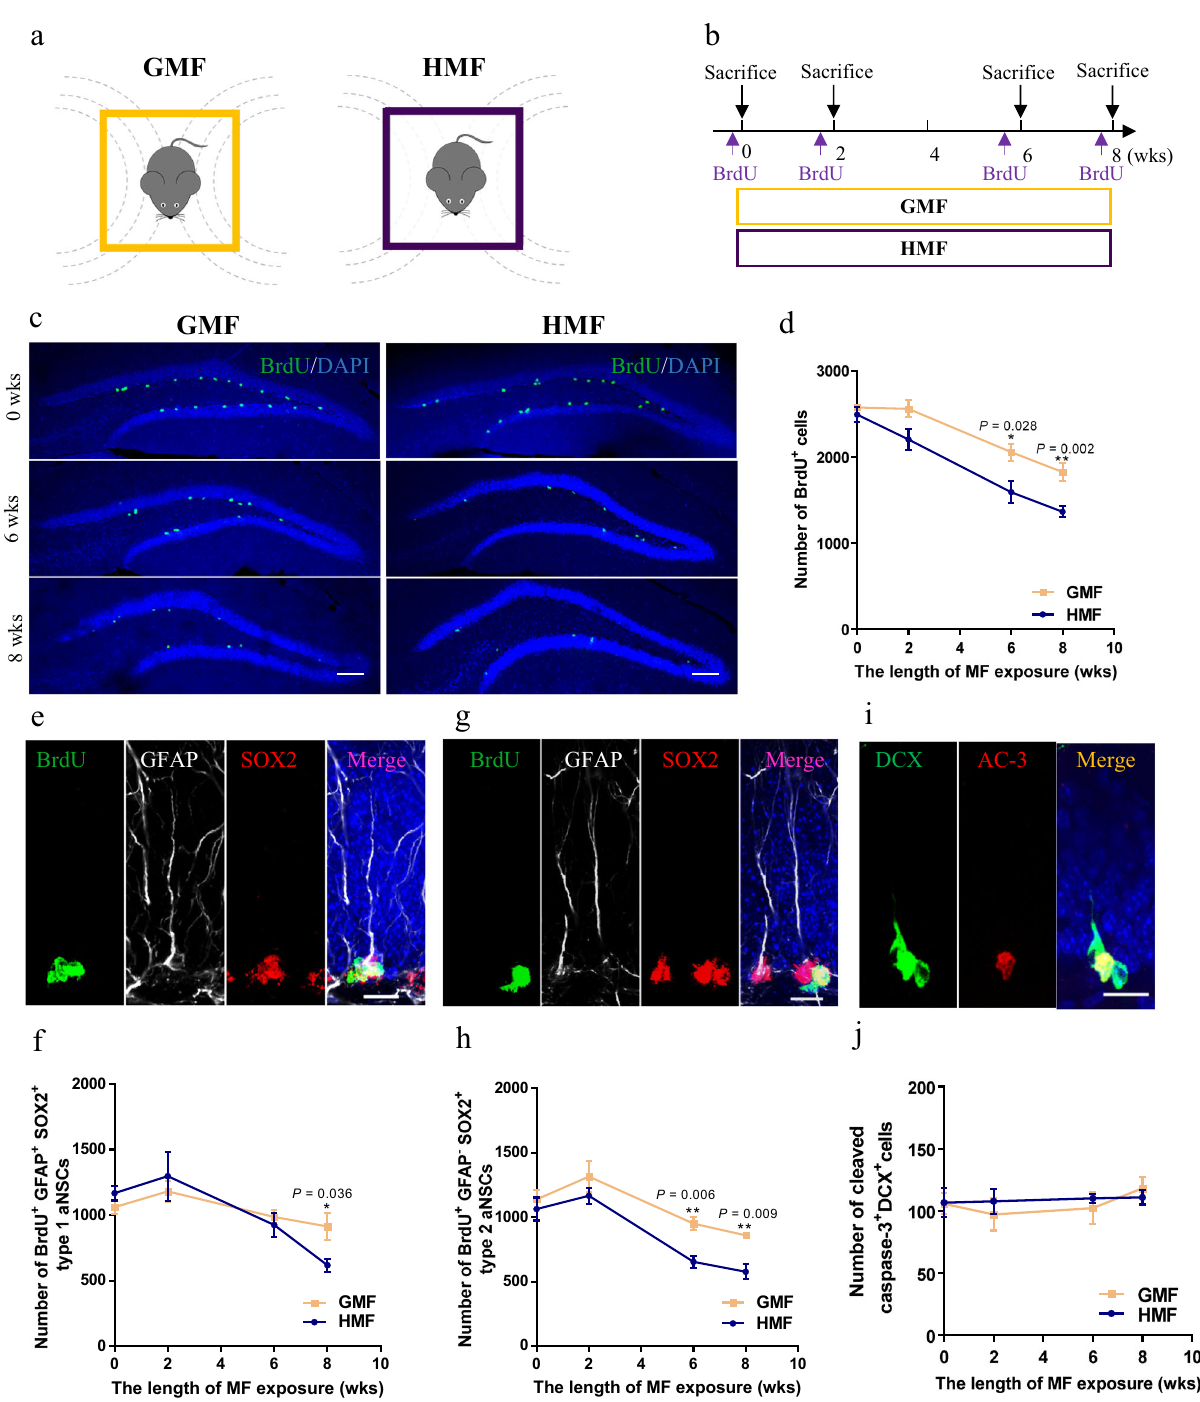
Fig. 1 Long-term HMF exposure decreased the proliferation of aNSCs in the DG of mice. a Schematic diagram of magnetic fi eld exposure to adult mice. b Experiments timeline for cell proliferation analysis during HMF or GMF exposure. c Representative images of BrdU + cells in the DG after 2-h BrdU pulse labeling at 0-, 6-, 8-weeks of GMF- or HMF-exposure. Scale bar = 200 μ m. d Quanti fi cation of numbers of BrdU + cells in GMF- and HMF-exposed mice (GMF versus HMF, two-way ANOVA, F(1, 23) = 24.96, P < 0.0001). e Representative images of BrdU + GFAP + Sox2 + type 1 aNSCs in the adult DG. Scale bar = 20 μ m. f Quanti fi cation of numbers of BrdU + GFAP + Sox2 + type 1 aNSCs in GMF- and HMF-exposed mice (GMF versus HMF, two-way ANOVA, F(1, 20) = 0.2978, P = 0.5913). g Representative images of BrdU + GFAP - Sox2 + type 2 aNSCs in the adult DG. Scale bar = 20 μ m. h Quanti fi cation of numbers of BrdU + GFAP − Sox2 + type 2 aNSCs in GMF- and HMF-exposed mice (GMF versus HMF, two-way ANOVA, F(1, 21) = 14.81, P = 0.0009). i Representative images of brain section stained with DCX and activated caspase-3 (AC-3) in the adult DG. Scale bar = 20 μ m. j Quanti fi cation of numbers of AC-3 + DCX + cells in GMF- and HMF-exposed mice (GMF versus HMF, two-way ANOVA, F(1, 24) = 0.186, P = 0.67). GMF, n = 4 mice, HMF, n = 4 mice. Data are presented as mean ± SEM. All data were analyzed by two-way ANOVA, and the two-tailed unpaired t test for two-group comparisons at each time